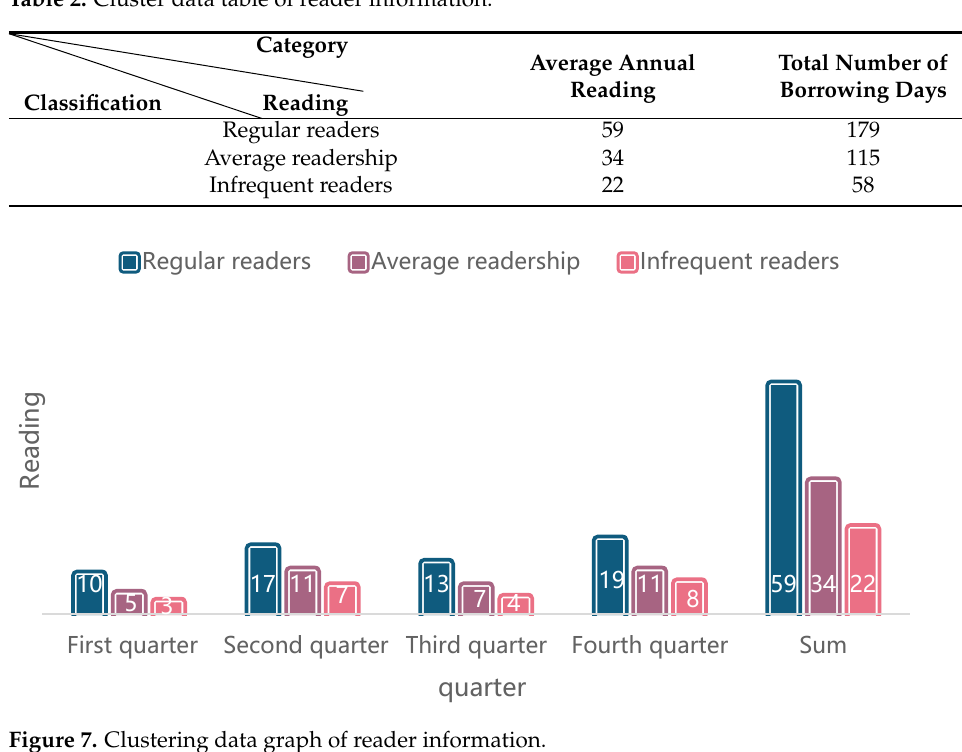
Table 2. Cluster data table of reader information.